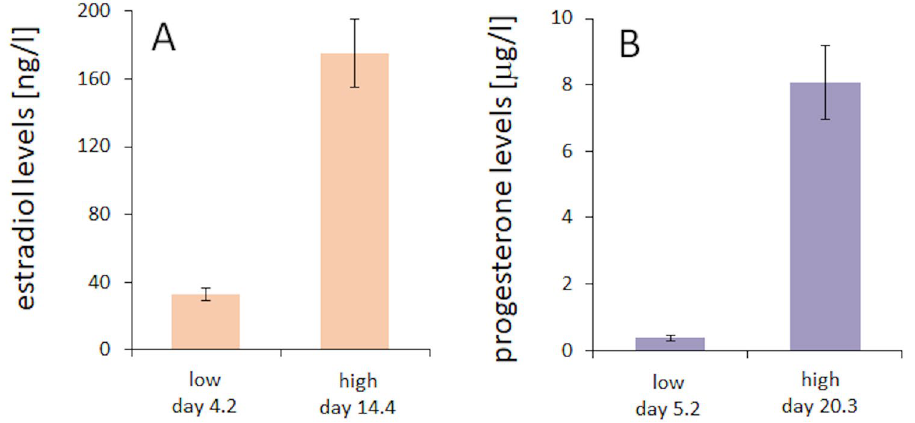
Figure 2. Minimal and maximal hormone levels. Average levels of minimal and maximal estradiol ( A ) and progesterone ( B ) levels. Data are represented as mean ±